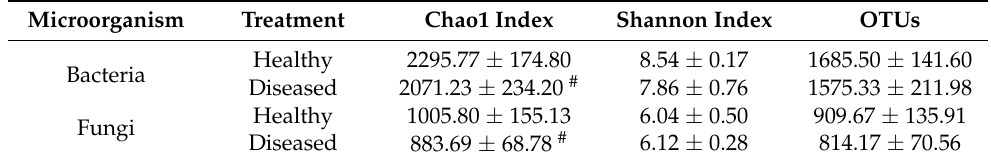
Table 1. Diversity indexes and OTU distribution of bacteria and fungi in healthy and decline disease bayberry rhizosphere